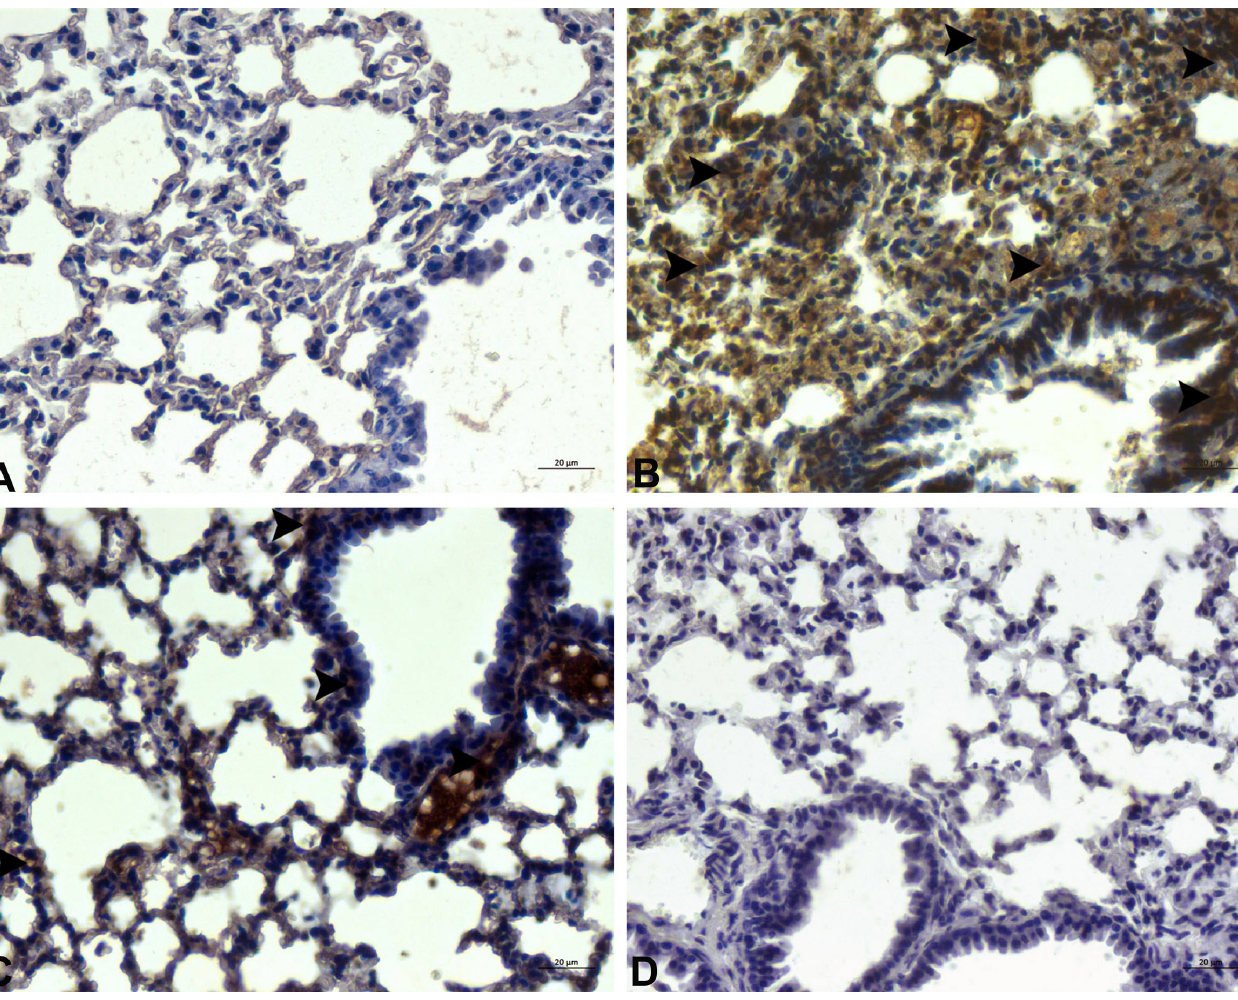
FIGURE 2 - Lung tissue, control group, negative expression of NF-κB and IL-6 (A), BLM group (arrowheads), severe IL-6 expression determined in the bronchial-bronchiolar epithelium, perivascular, peribronchiolar, and interstitial tissues (B), BLM+Theo group, bronchial-bronchiolar epithelium, perivascular, peribronchiolar, and interstitial tissues IL-6 expression detected at mild levels (C), Theo group, no obvious expression of NF-κB or IL-6 (D), IHC-P, Bar: 20